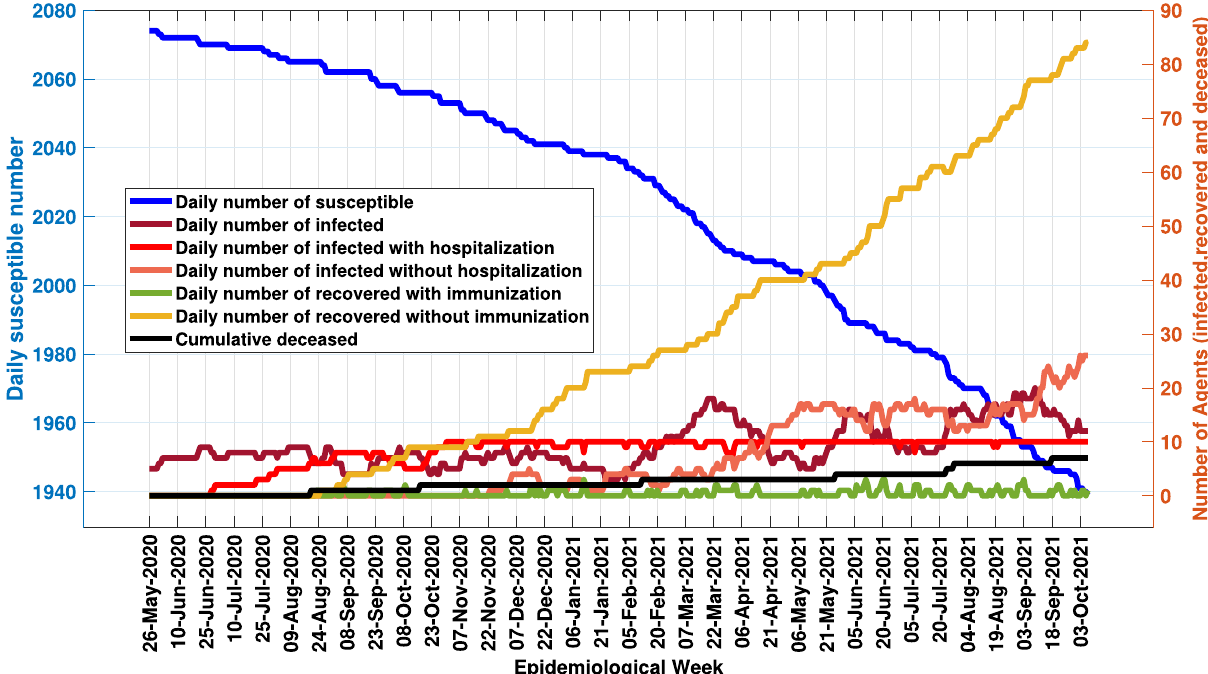
Figure 14. An example of the obtained solution provided by MCovidSim-2 framework with updated sensitive parameters—19th solution.